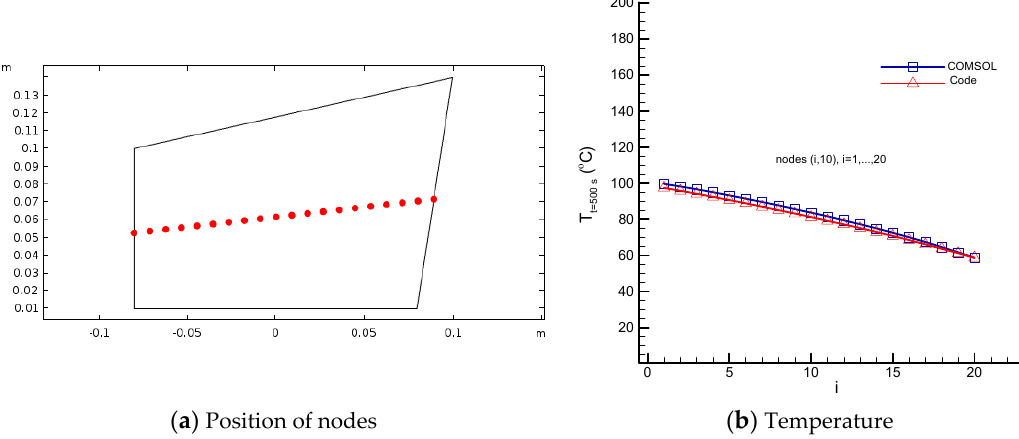
Figure 6. Comparison of temperature at nodes ( i , j ) , i = 1, ... , M ; j = 10 at the final time t f = 500 s obtained from the explicit solver and the finite-element software COMSOL. The position of nodes ( a ) and the temperature comparison ( b ).